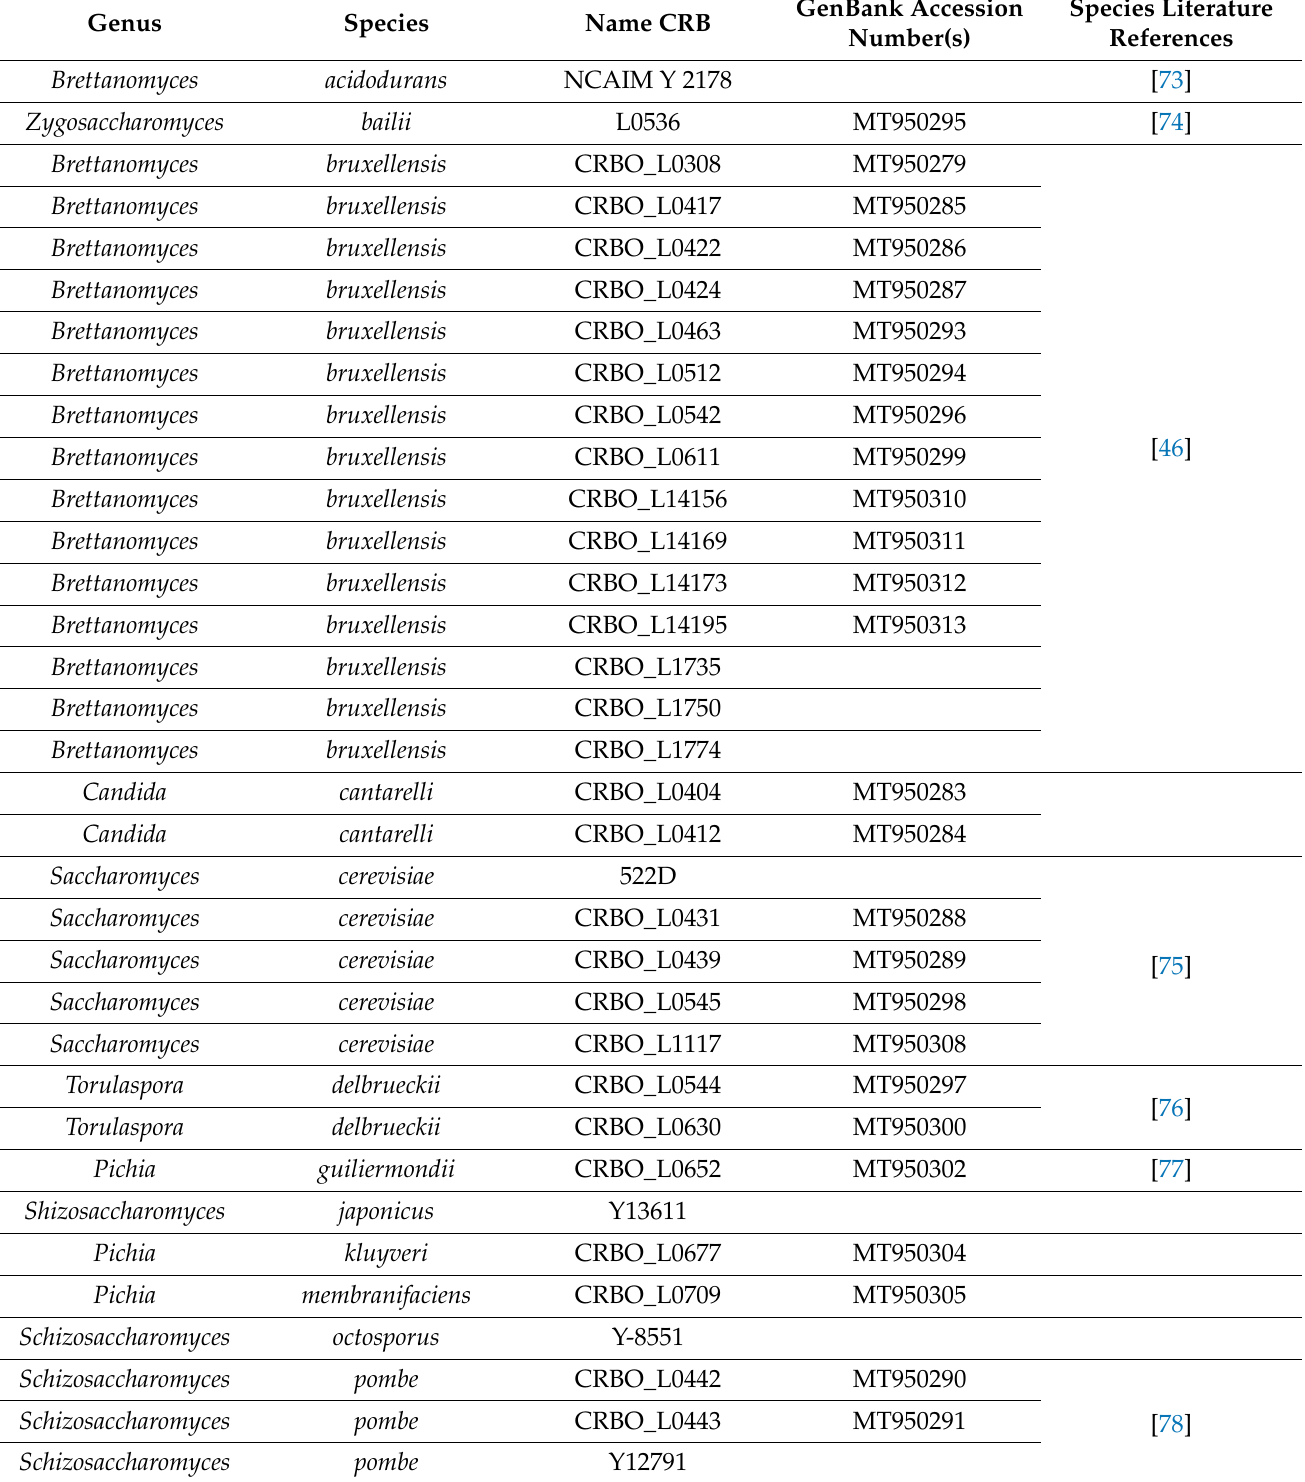
Table A1. List of the strains added to the oenological laboratory specific database with GenBank accession number(s).